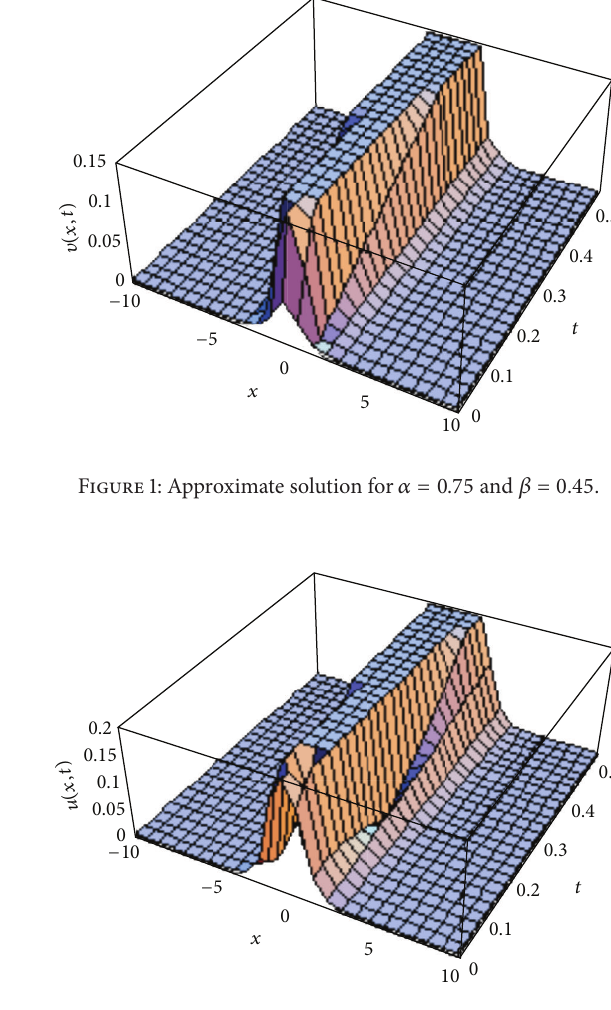
Figure 2: Approximate solution for 𝛼 = 0.75 and 𝛽 = 0.45 .